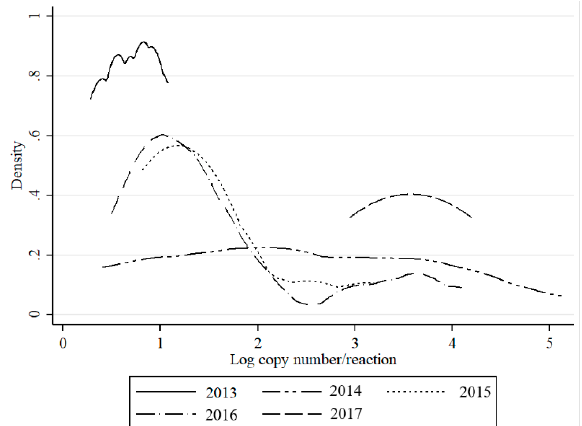
Figure 4. Distribution of estimated RNA copy numbers per sample (logarithm) values of QRT-PCR for SBV detection by kernel density plot in respect to year of sampling.